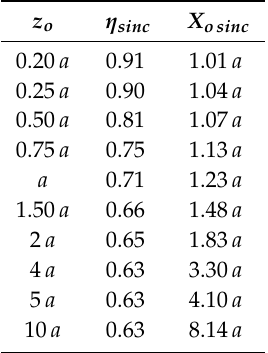
Table A1. Values of η sinc , and X osinc for different values of the distance z o